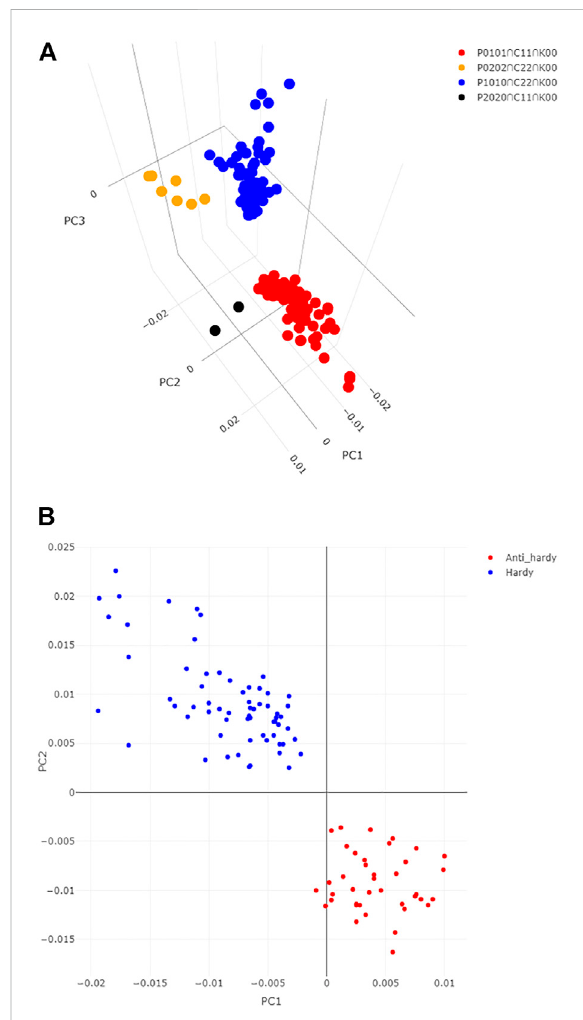
FIGURE 2 Distinction of genes associated with cold acclimation from the others. (A) Distinction of the 63 WHGs from the other three groups of DEGs identi fi ed in DEFE analysis as revealed by their scores of the fi rst three principal components. (B) Distinction of the 64 cold hardy genes from the 39 anti-hardy genes revealed by their scores of the fi rst two principal components. Where, PC1, PC2, and PC3 are the principal components 1, 2, and